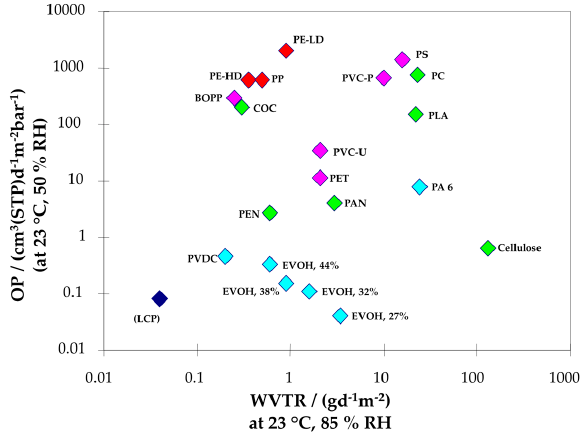
Figure 5. Comparison of oxygen permeability (OP) and water vapour transmission rate (WVTR) properties for different polymers normalized to 100 µm thickness. Source: Fraunhofer IVV [55].